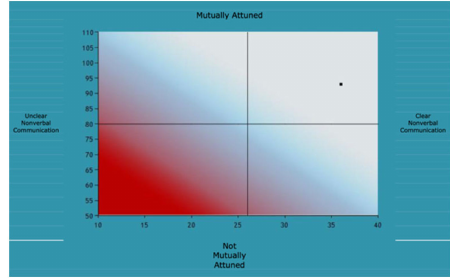
Figure A5. Joanna and Mrs. Townsend.